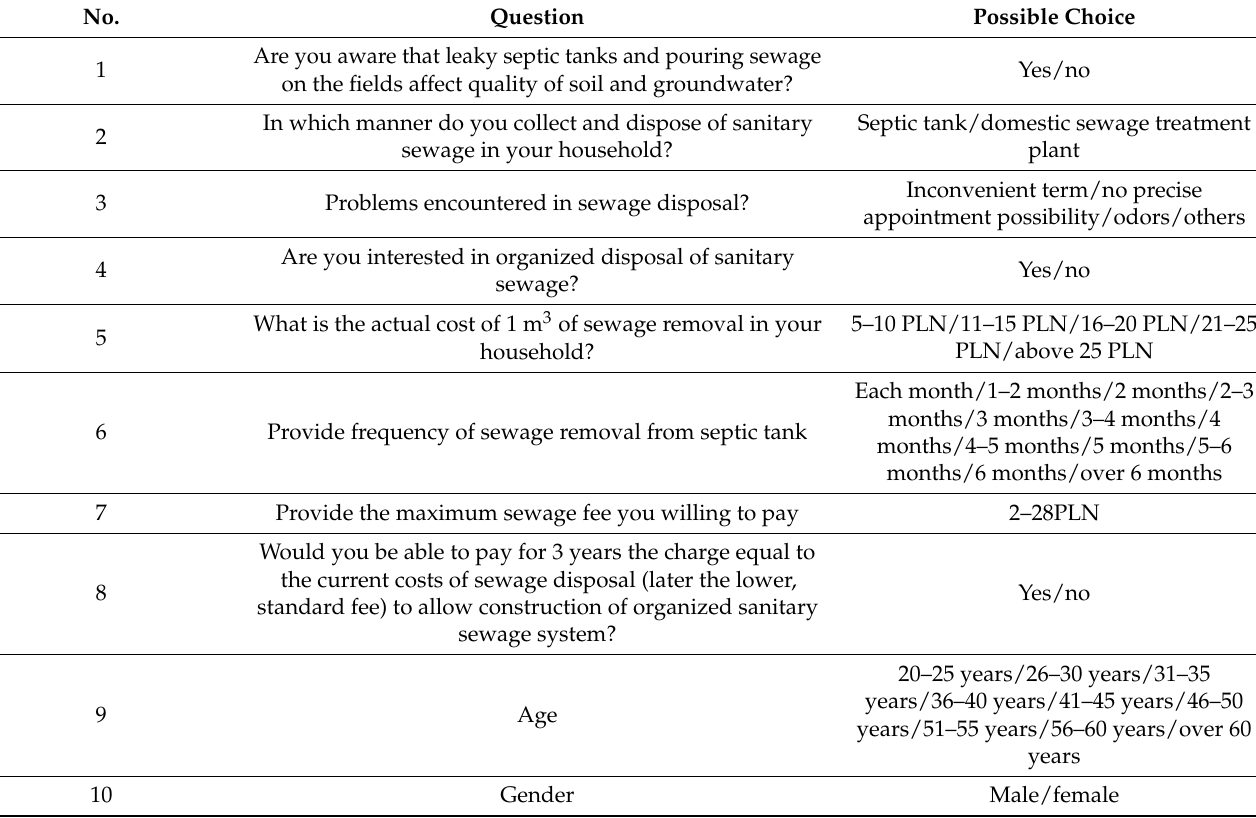
Table 2. WTA (willingness-to-accept ) and WTP (willingness-to-pay) questionnaire used in the